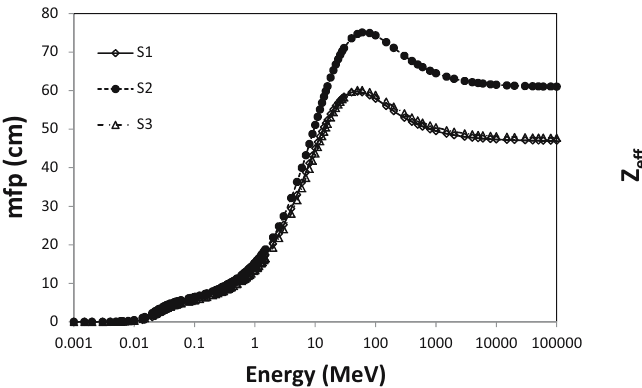
Figure 8: The calculated Z e ff as a function of gamma - ray